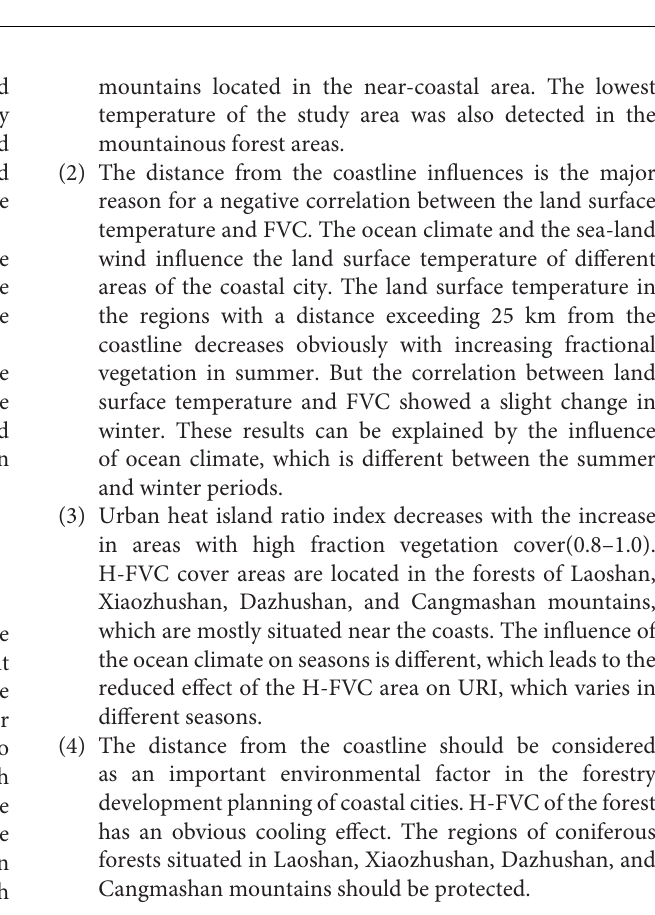
FIGURE 11 | Variations of URI and H-FVC proportion from 2000 to 2020 (A) variations of URI and H-FVC proportion in summer and (B) variations of URI and H-FVC proportion in